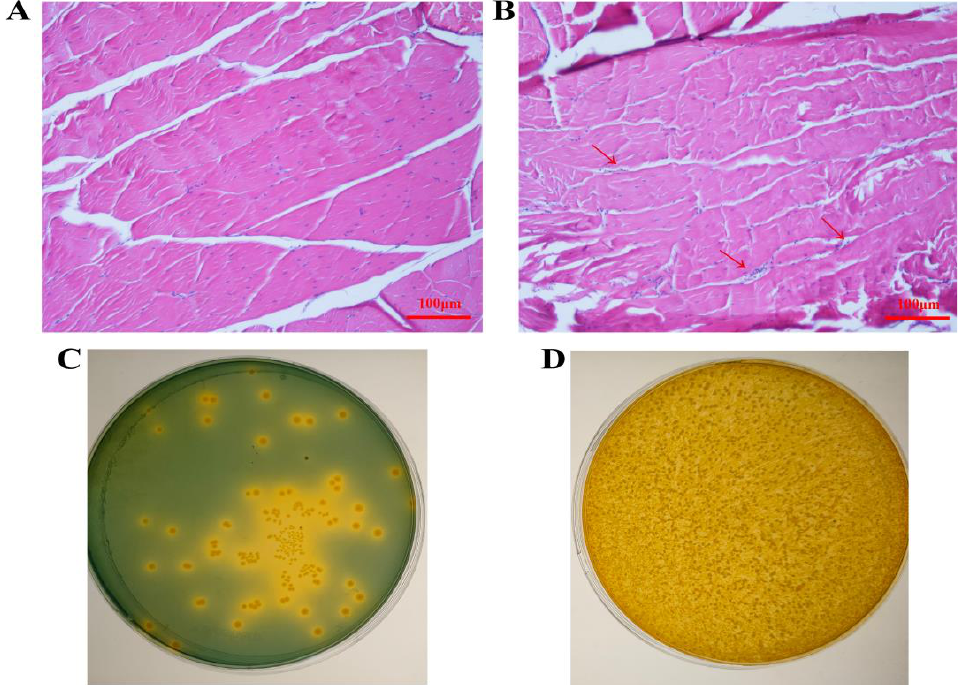
Figure 7. Histological sections of muscles and total viable bacteria count after LvMEF2 interference. ( A , C ) control group(PBS); ( B , D ) dsMEF2 group. The arrows in panel (B) refers to the region of nuclear agglutination.